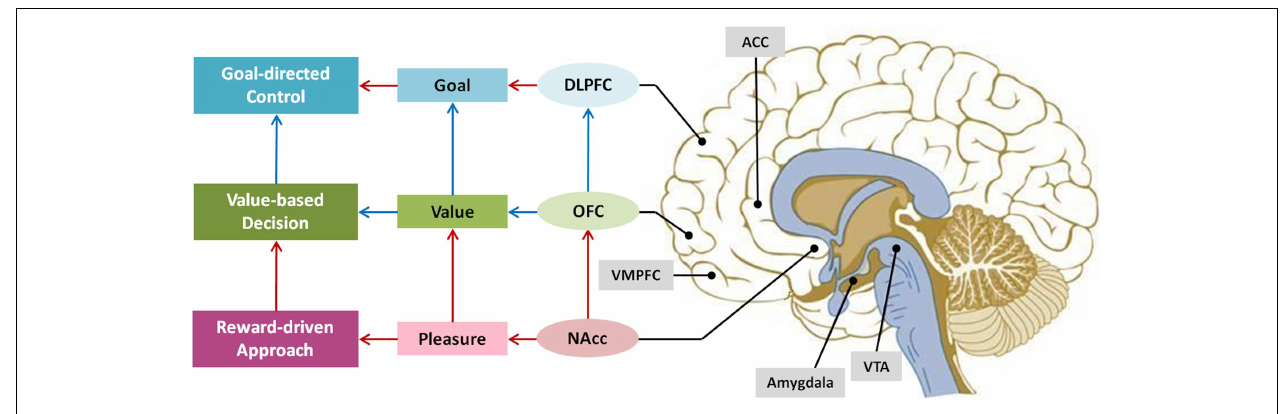
FIGURE 3 | Key brain regions related to motivational